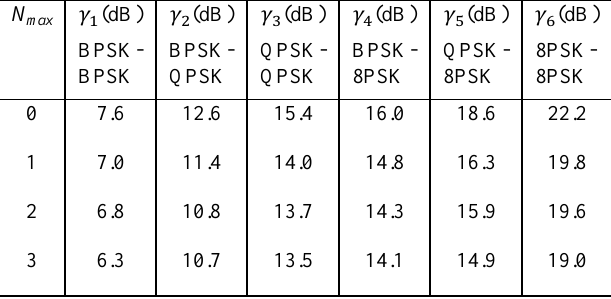
Table 3. Switch boundaries under different N max